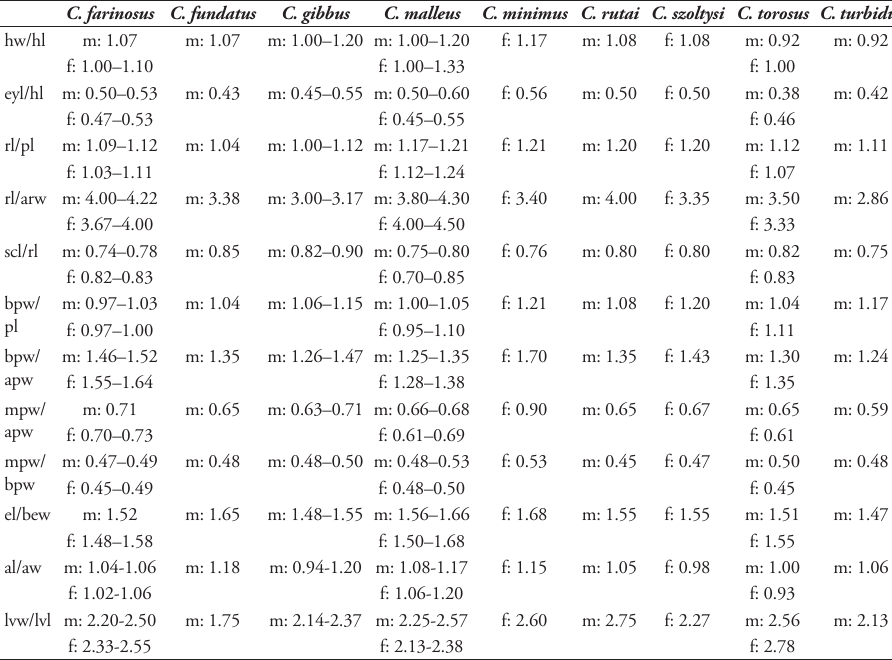
Table 1. Indices for species of Callistomorphus Perr., where: m – male, f –